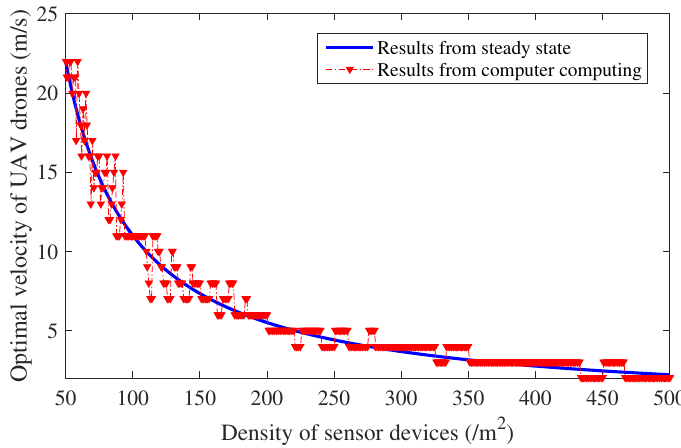
Figure 5. Optimal speed for UAVs under different sensor device